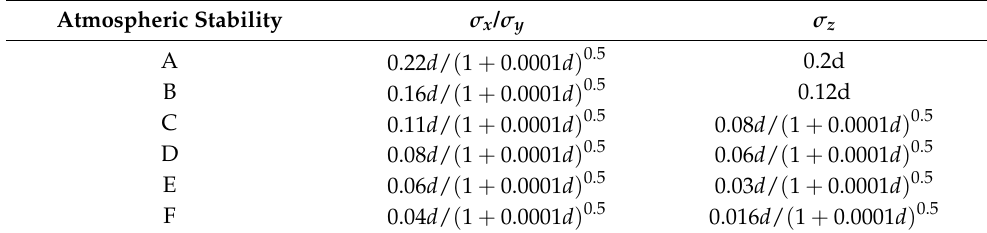
Table 1. Table of diffusion coefficients.